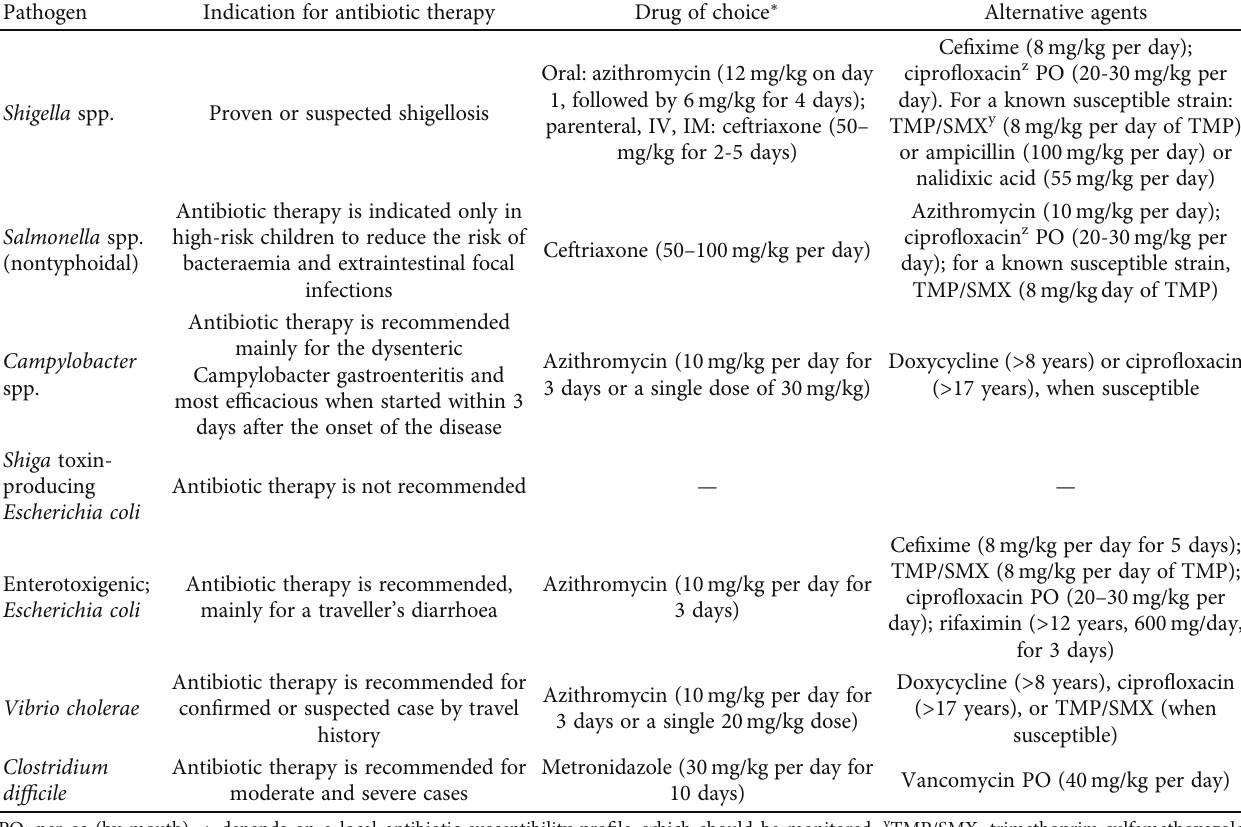
Table 2: Antimicrobial therapy for infective